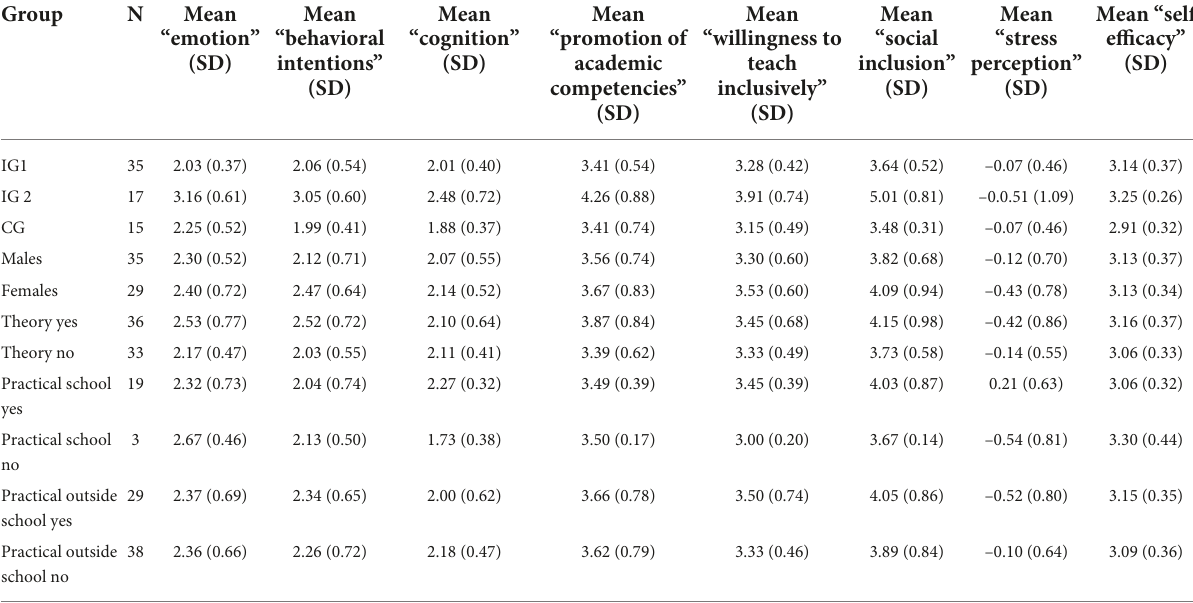
TABLE 2 Descriptive statistics of the dependent variables at